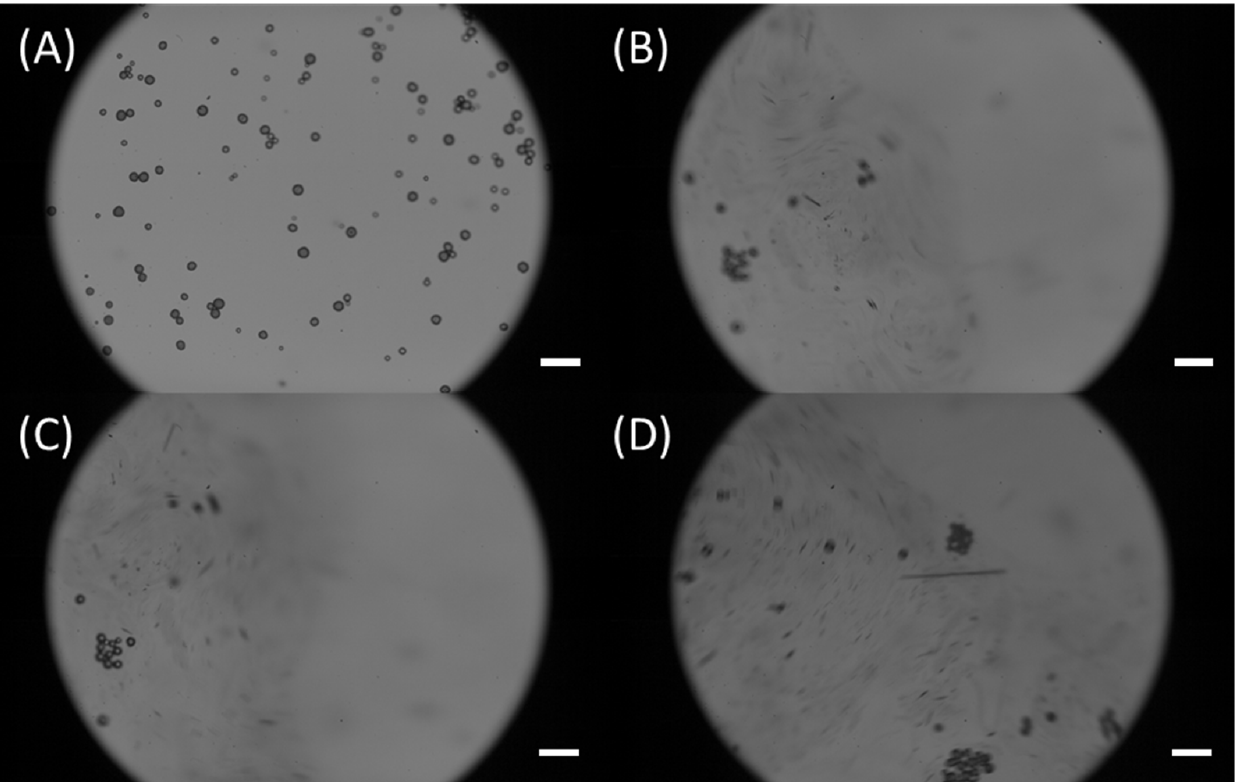
Figure 2. Aggregation induced due to high Nile Red concentrations. ( A ) First frame (0.0003 s)— Moment in which the Nile Red solution is placed on the glass slide right after the preparation; ( B ) Second frame (0.0006 s)—Beginning of the aggregation; ( C ) Third frame (0.0010 s)—Initial particle clusters can be observed; ( D ) Fourth frame (0.0013 s)—Higher levels of aggregation are observed; Scale bars are 100 µm.